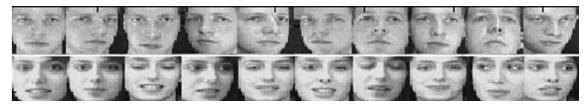
Figure 8: Sample face images from the ORL database along with variations in facial expressions and poses.